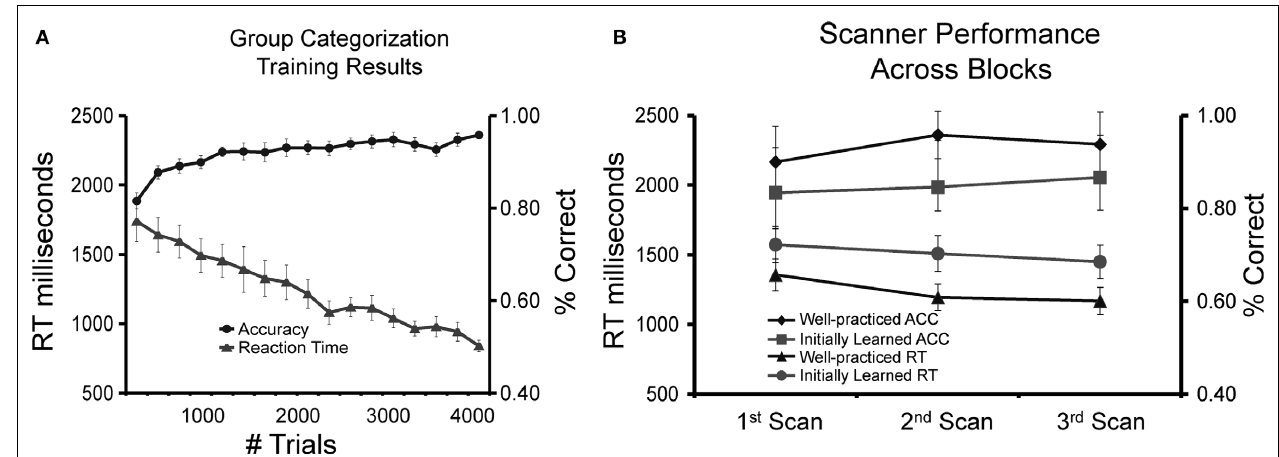
FIGURE 3 | Behavioral results. (A) Group accuracy and reaction time ( N = 10) during the categorization task throughout 6 days of training. (B) Group accuracy and reaction time across blocks during the scanning session for the well-practiced and initially learned categorization